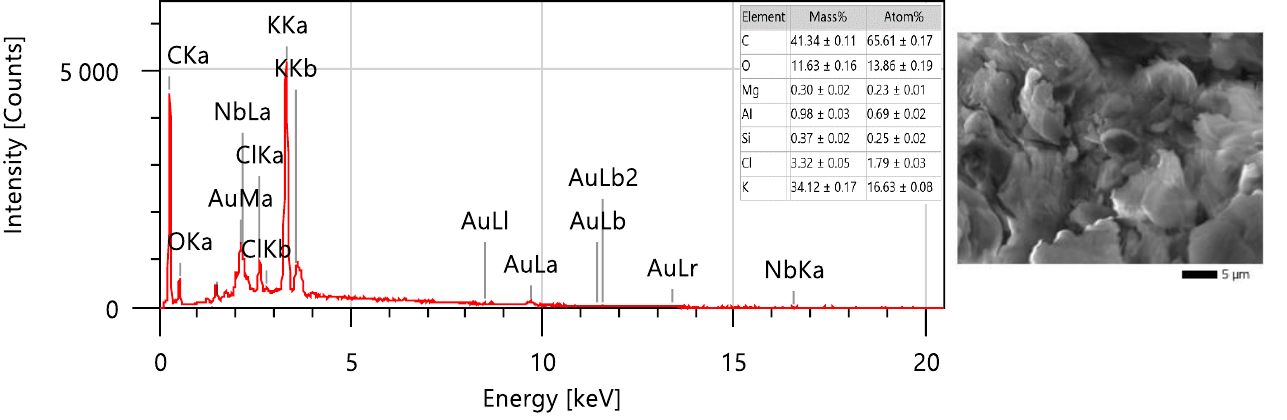
Figure 6. The different elements present in almond shell. Figure 2. The different elements present in almond